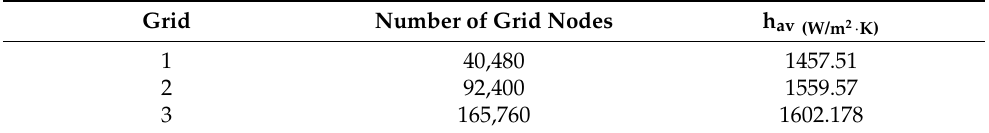
Table 5. Grid independence